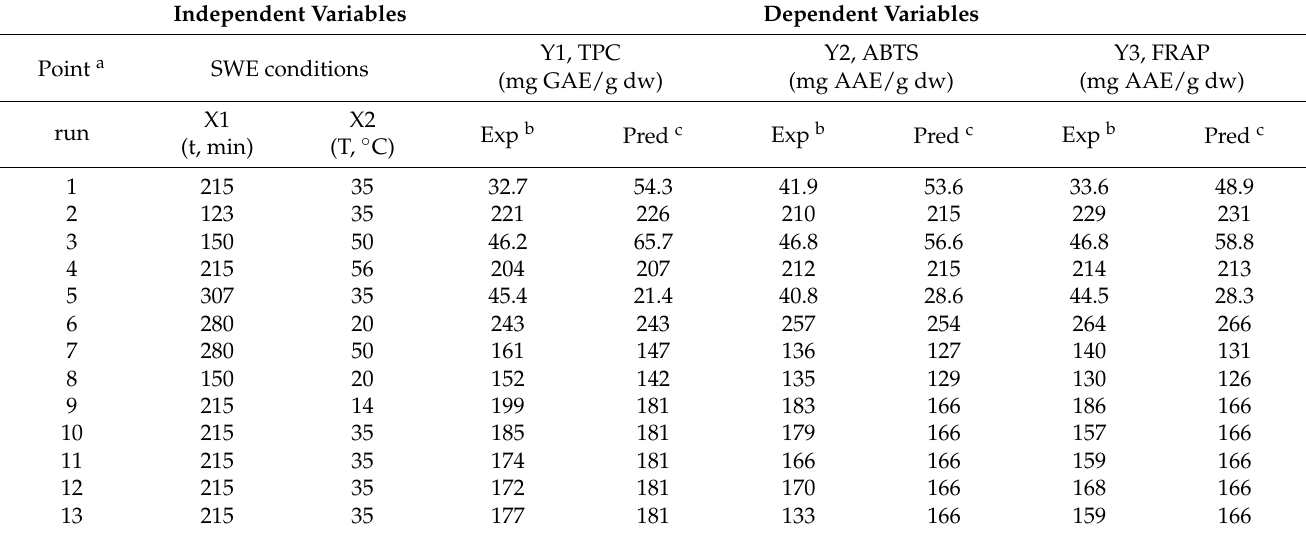
Table 1. Experimental and predicted values of TPC (Y1, mg GAE/g dw), ABTS (Y2, mg AAE/g dw) and FRAP (Y2, mg AAE/g dw) of vine-canes’ SWE extracts obtained by central composite design